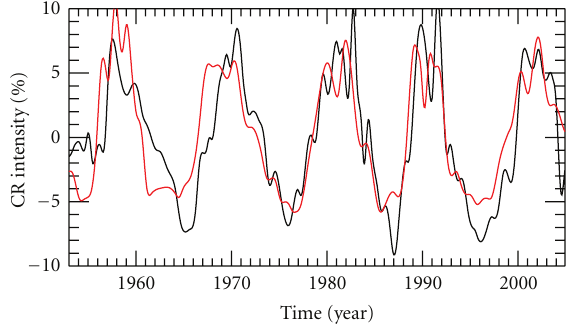
Figure 8: Superposition of the ∼ 11 yr mode and the QBOs computed from CLI (inverted, black line) and SA (red line)